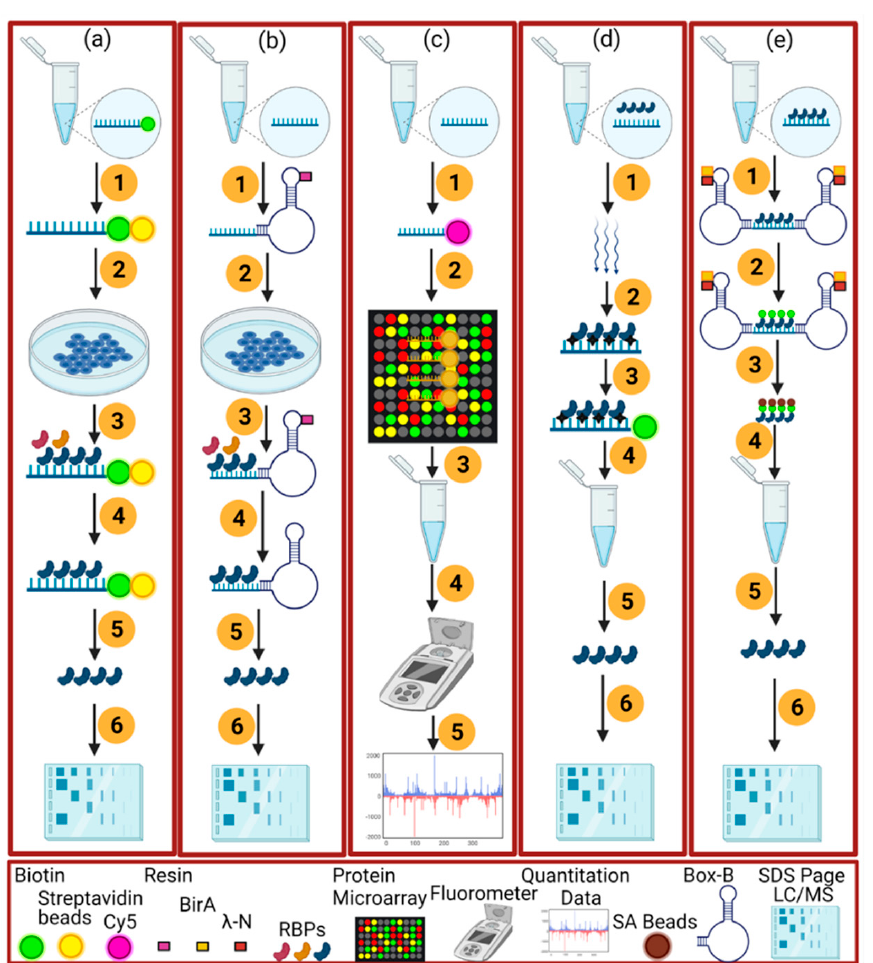
Figure 3. The graphical representations of the in vivo ( a – c ) and in vitro ( e , d ) RNA-centric methods. ( a ) the schematic of the end-biotinylated-RNA pulldown method which consists of these steps; biotin tagged RNA is transcribed in vitro and incubated with streptavidin beads (1), the addition of a cellular extract (2), the connection of RBPs with the associated RNA (3), non-targeted RBPs are washed (4), boiling of beads and RNase treatment to elute the RBPs (5), running of SDS-Page gel and mass spectrometry (6). ( b ) an aptamer-tagged RNA method to identify the RBPs in in vivo by not using the UV cross-linking mechanism as in ( a ). It consists of these steps, the linking of in vitro transcribed RNA with an RNA tag (blue) and resin (1), binding of RBPs with the RNA upon the addition of a cellular extract (2, 3), washing of specific and non-targeted RBPs (4), elution of the RBPs by using imidazole for Cys4 or biotin for the S1 aptamer method (5), LC/MS (6). ( c ) a protein microarray method followed by: in vitro RNA is transcribed by using the Cy5 (1), complex formation of RNA with the spotted 9400 proteins (2), washing of proteins (3), use of fluorescence meter to quantitate RNA bound with the microarray proteins (4, 5). However, ( d ) an in vitro UV cross-linking-based method as in plants (RIC, eRIC, OOPS) or other eukaryotes (RAP, PAIR, MS2-BioTRAP, TRIP). It consists of the UV cross-linking of RBPs inside the live cell (1, 2) the capturing of RBPs with the biotin (3), purification and isolation of RBPs (4, 5), SDS-Page gel and LC/MS (6). In the last ( e ), the non-UV cross-linking method RaPID is carried out by the following procedure: flanking of RNA with the BoxB RNA stem-loops (1), biotinylation of proteins by using the RaPID (LN-HA-BirA*) fusion protein linking with BoxB sites (2), capturing of biotinylated proteins with the SA beads (3), washing and elution of RBPs (4, 5) and SDS-Page Gel and LC/MS